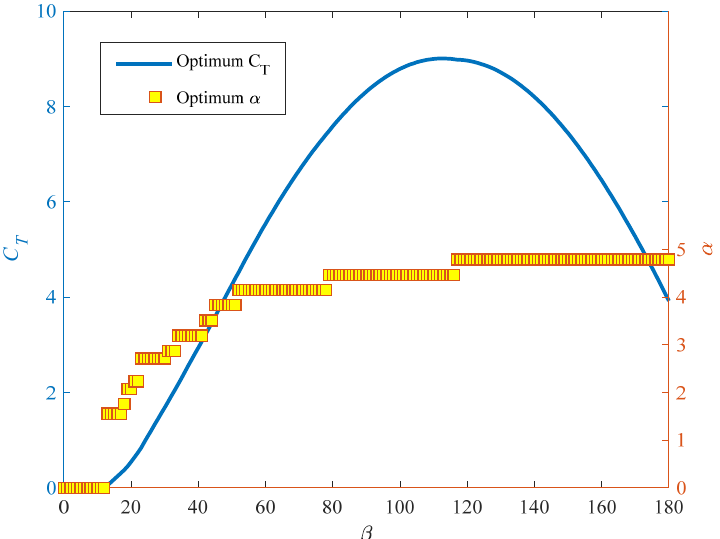
Figure 15. Maximum thrust at different relative wind angle with corresponding optimal spinning ratio.